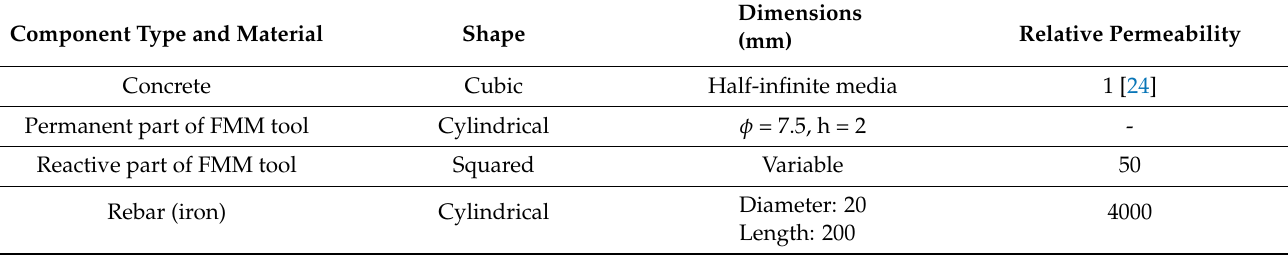
Table 1. General parametric set-up for all objects involved in all three